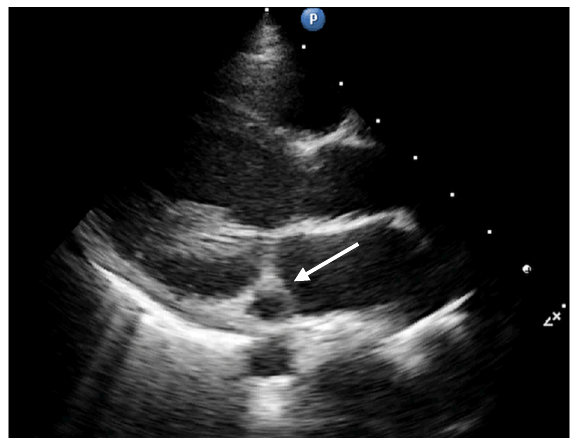
Figure 1. Electrocardiogram at admission.